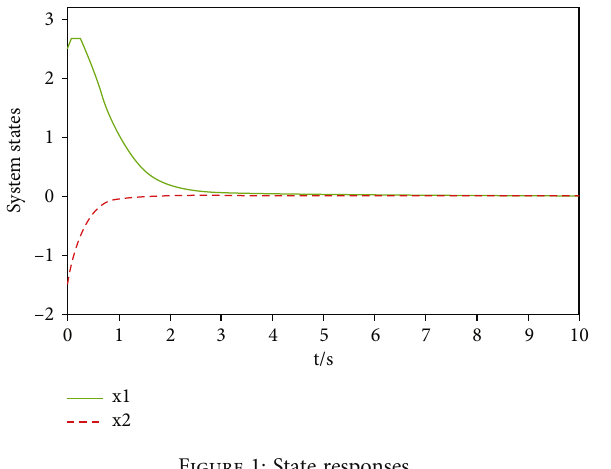
Figure 1: State responses.